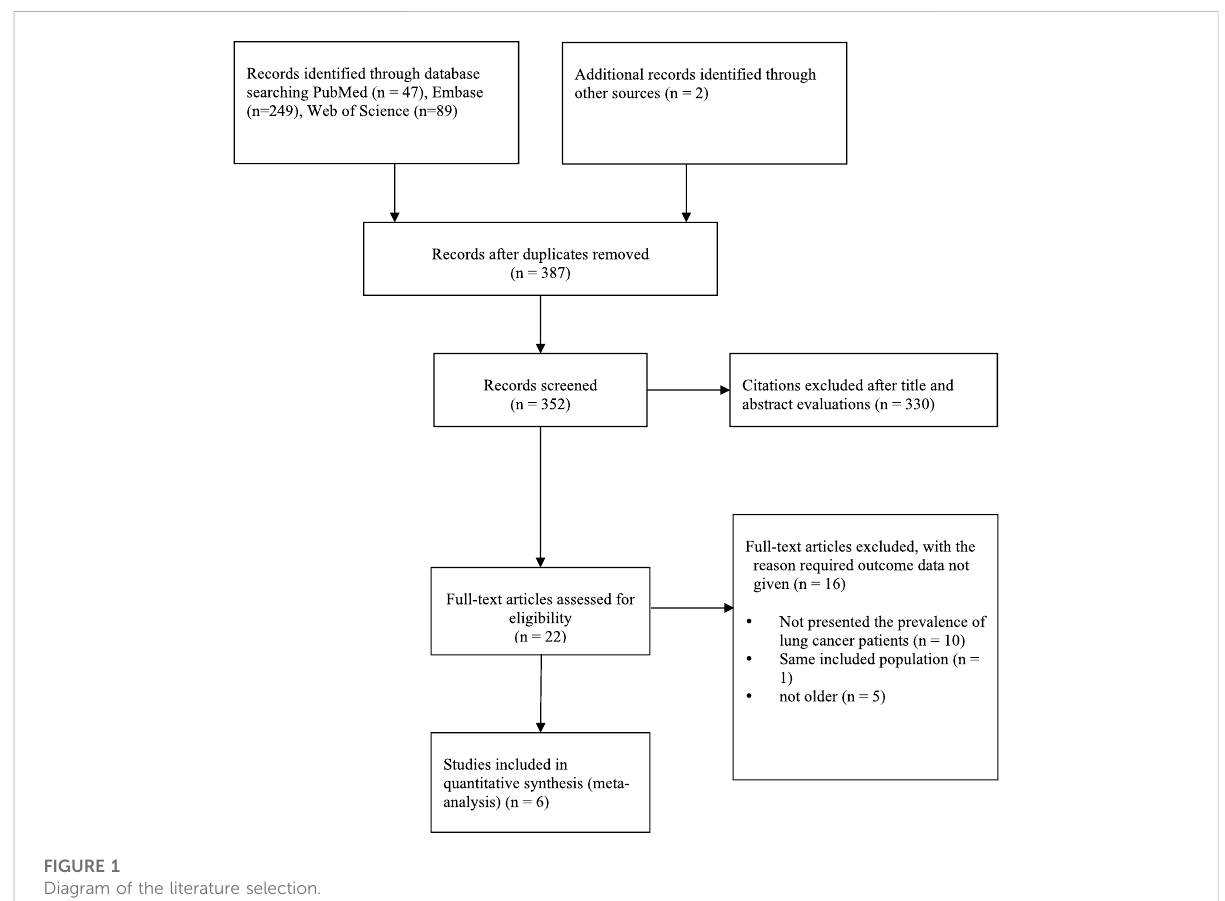
FIGURE 1 Diagram of the literature selection.